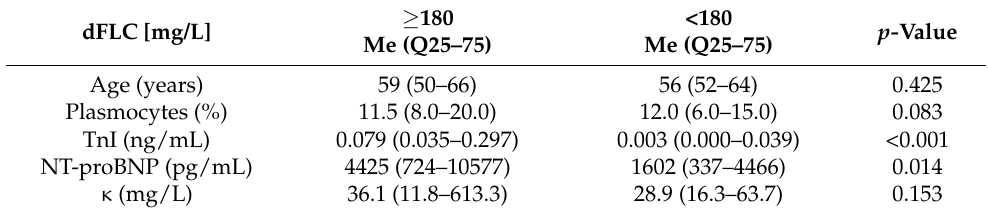
Table 5. Comparative analysis of study groups with involved and uninvolved free light chains— dFLC <180 and ≥ 180